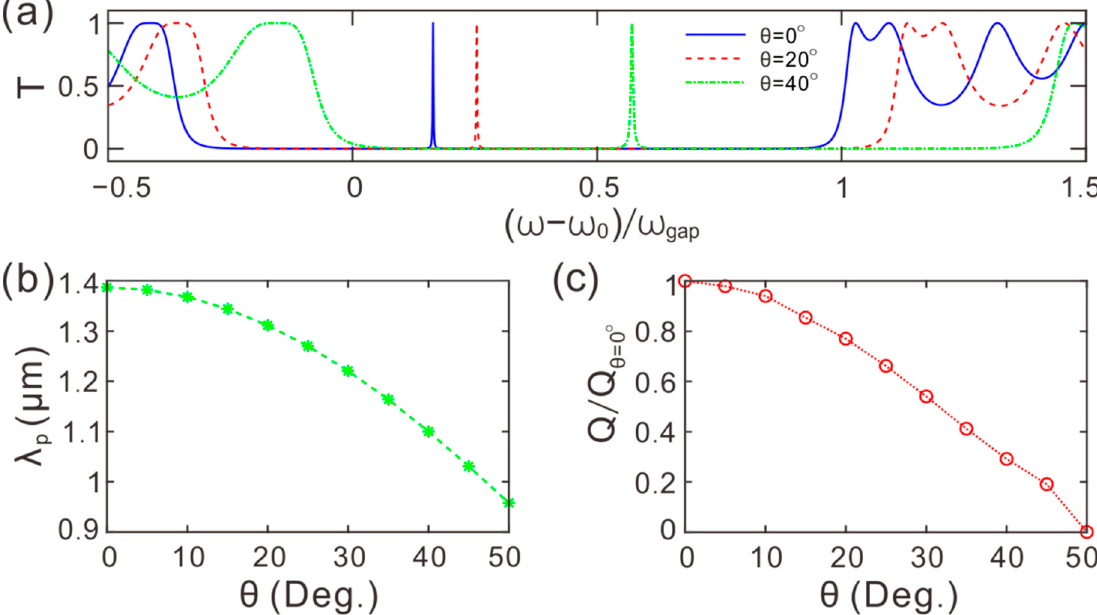
Figure 6. ( a ) Transmission spectra for different values of the incident angle. ( b ) Central wavelength of resonant state varying with the incident angle. ( c ) Quality factor of the resonant cavity changing with the incident angle. Periodic number of photonic crystal is set as N =